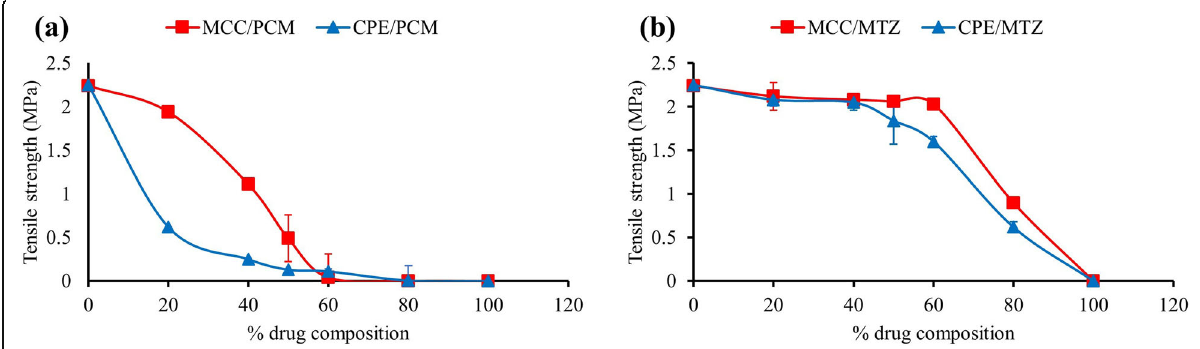
Fig. 3 Dilution potential plot of MCC and CPE using a PCM and b MTZ as model drugs